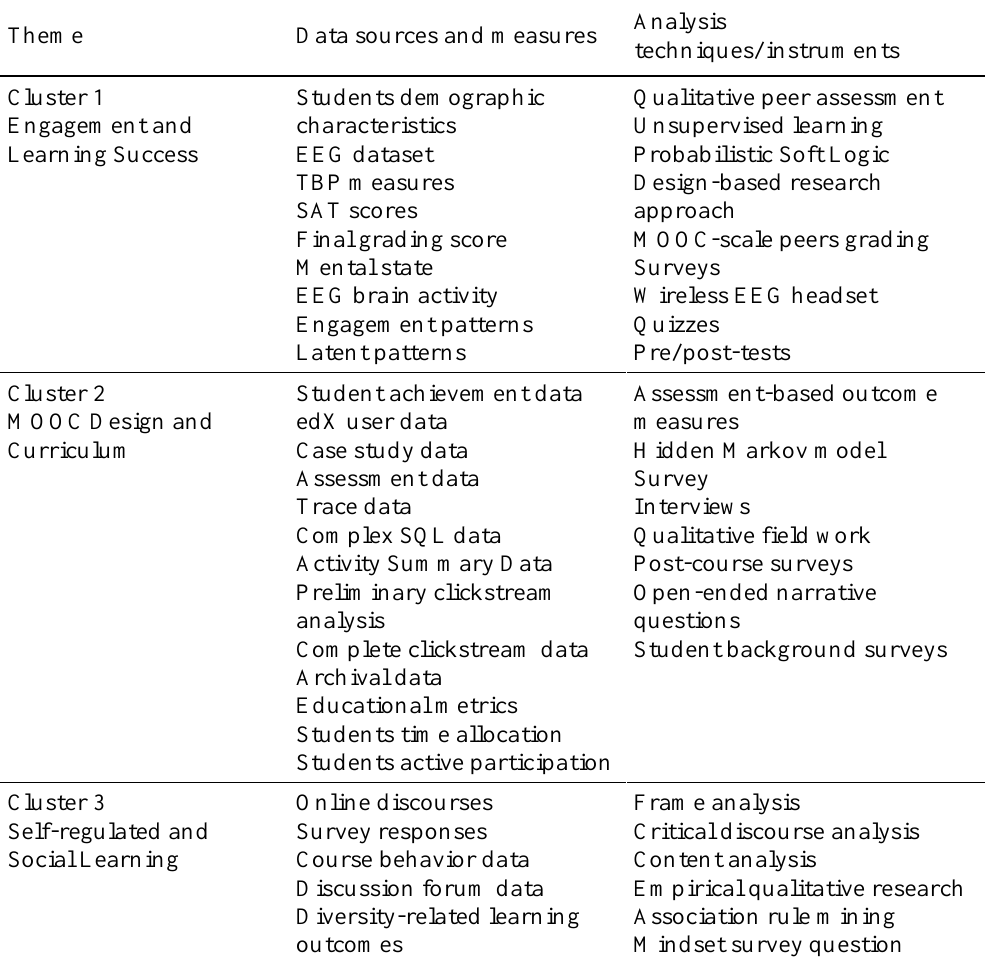
Phase 2 Research Characteristics of Discovered Research Themes Analysis Data sources and measures